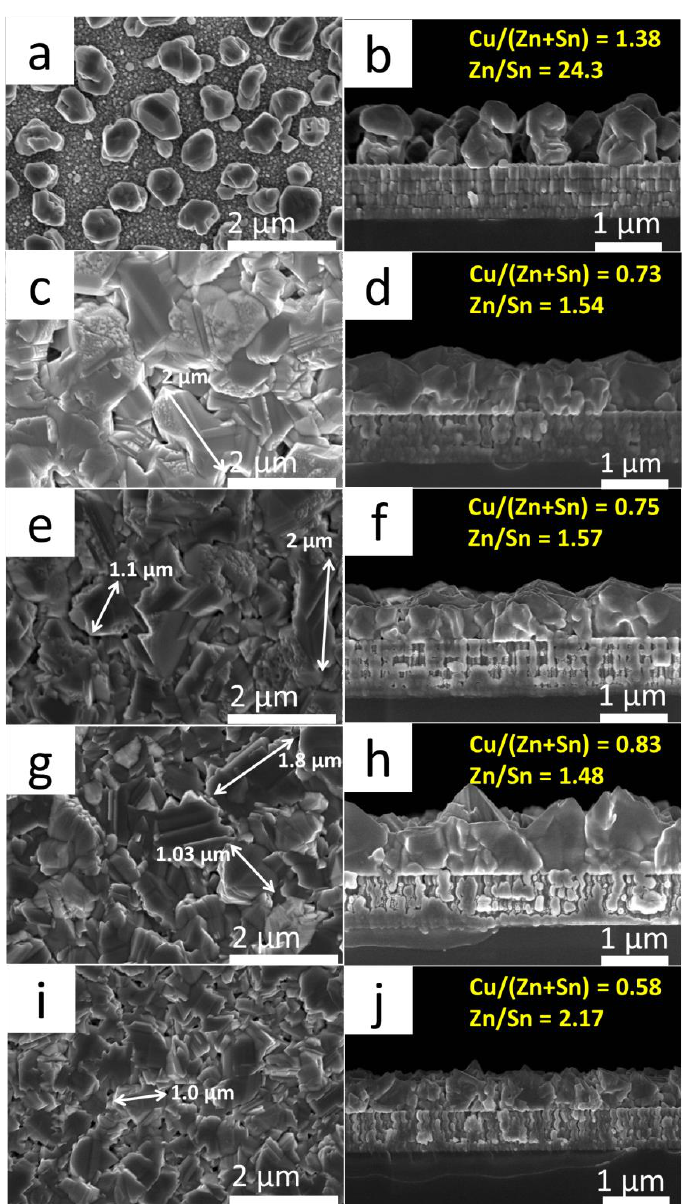
Figure 2. SEM surface and cross-sectional images of Cu 2 (Zn,Sn)Se 4 films prepared at various growth temperatures: ( a , b ) 550 ◦ C, ( c , d ) 480 ◦ C, ( e , f ) 440 ◦ C, ( g , h ) 380 ◦ C, and ( i , j ) 330 ◦